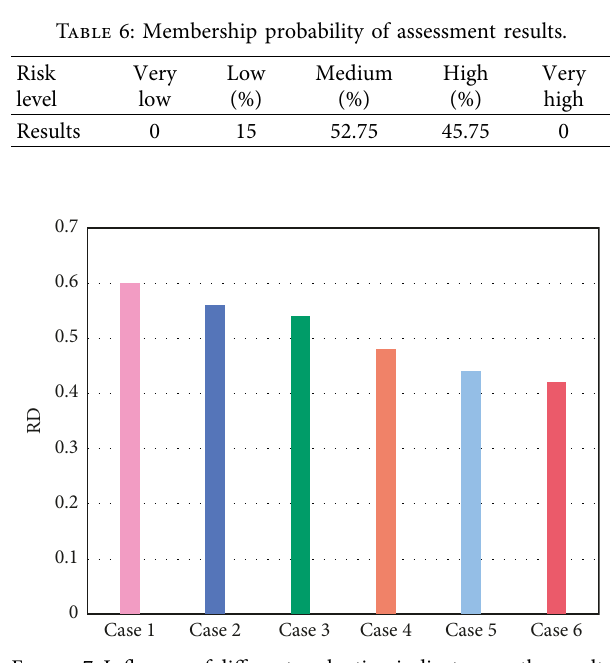
Figure 7: Influence of different evaluation indicators on the results of risk degree